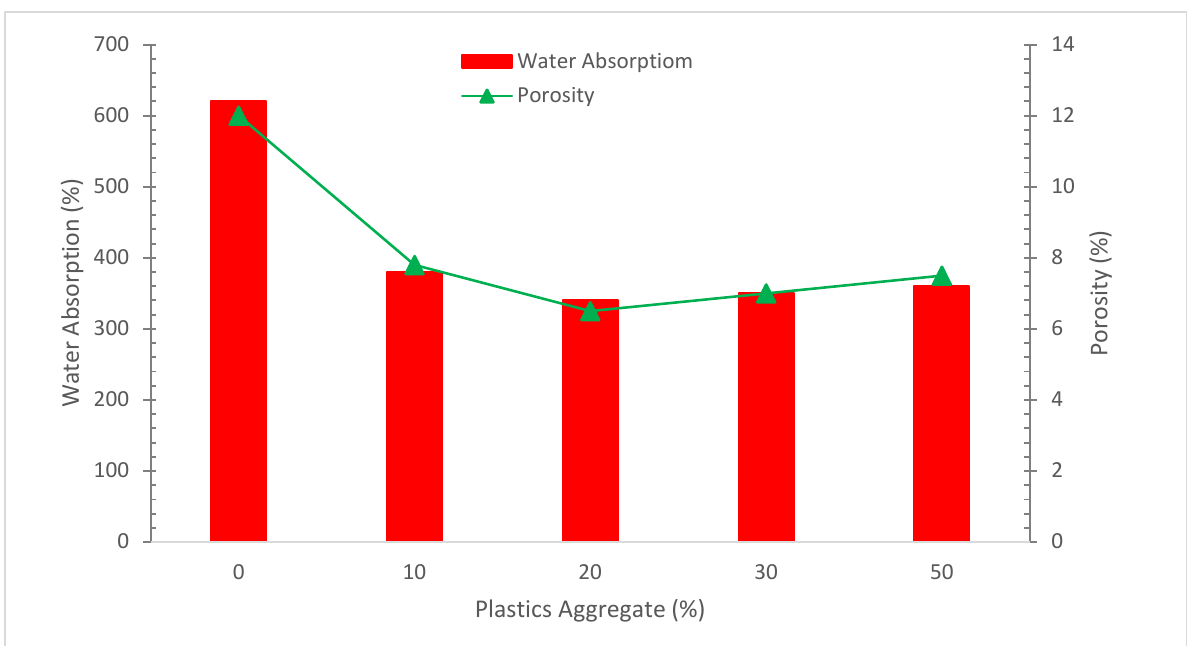
Figure 11. Water Absorption and Porosity: Data Source [22].